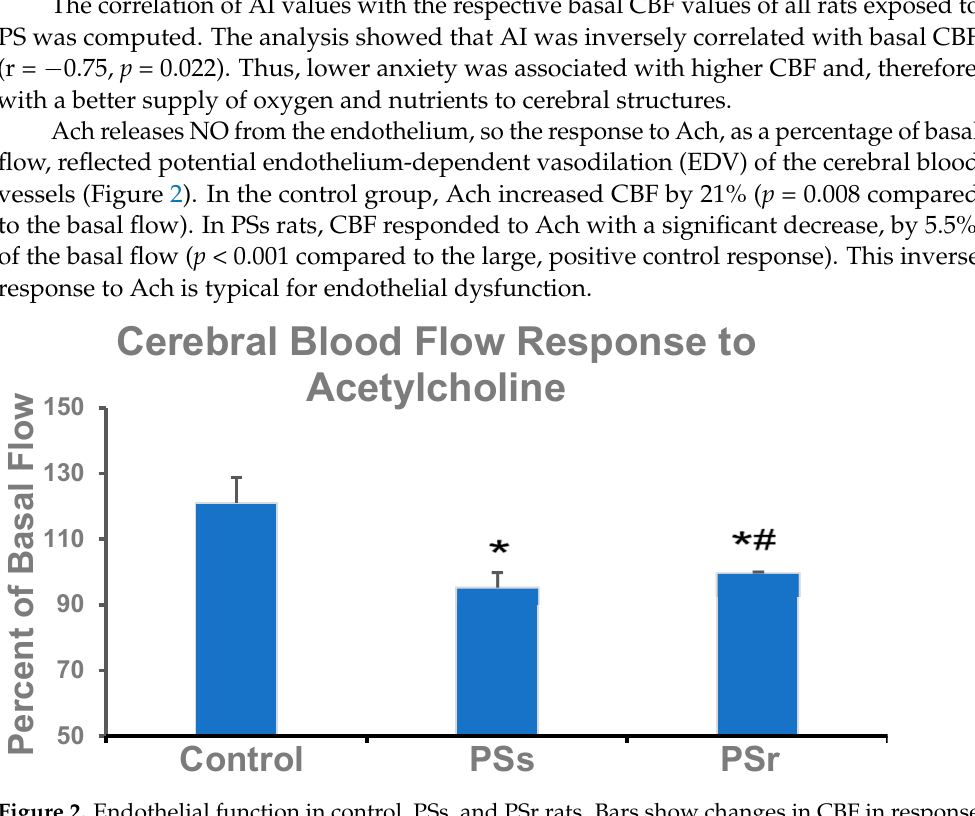
Figure 2. Endothelial function in control, PSs, and PSr rats. Bars show changes in CBF in response to acetylcholine as a percent of basal CBF. CBF, cerebral blood flow; PSs, PS-susceptible rats; PSr, PS-resilient rats. * Difference from the control response, p < 0.001. # Difference from the PSs response, p = 0.049.